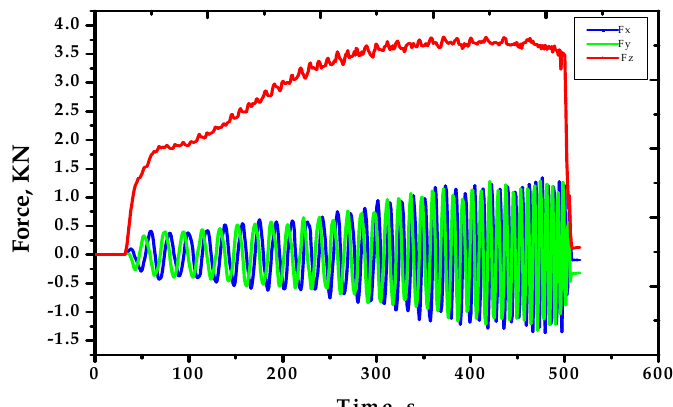
Figure 10. Forming forces in the three directions for the cone produced with run 1. Metals 2017 , 7 , 484